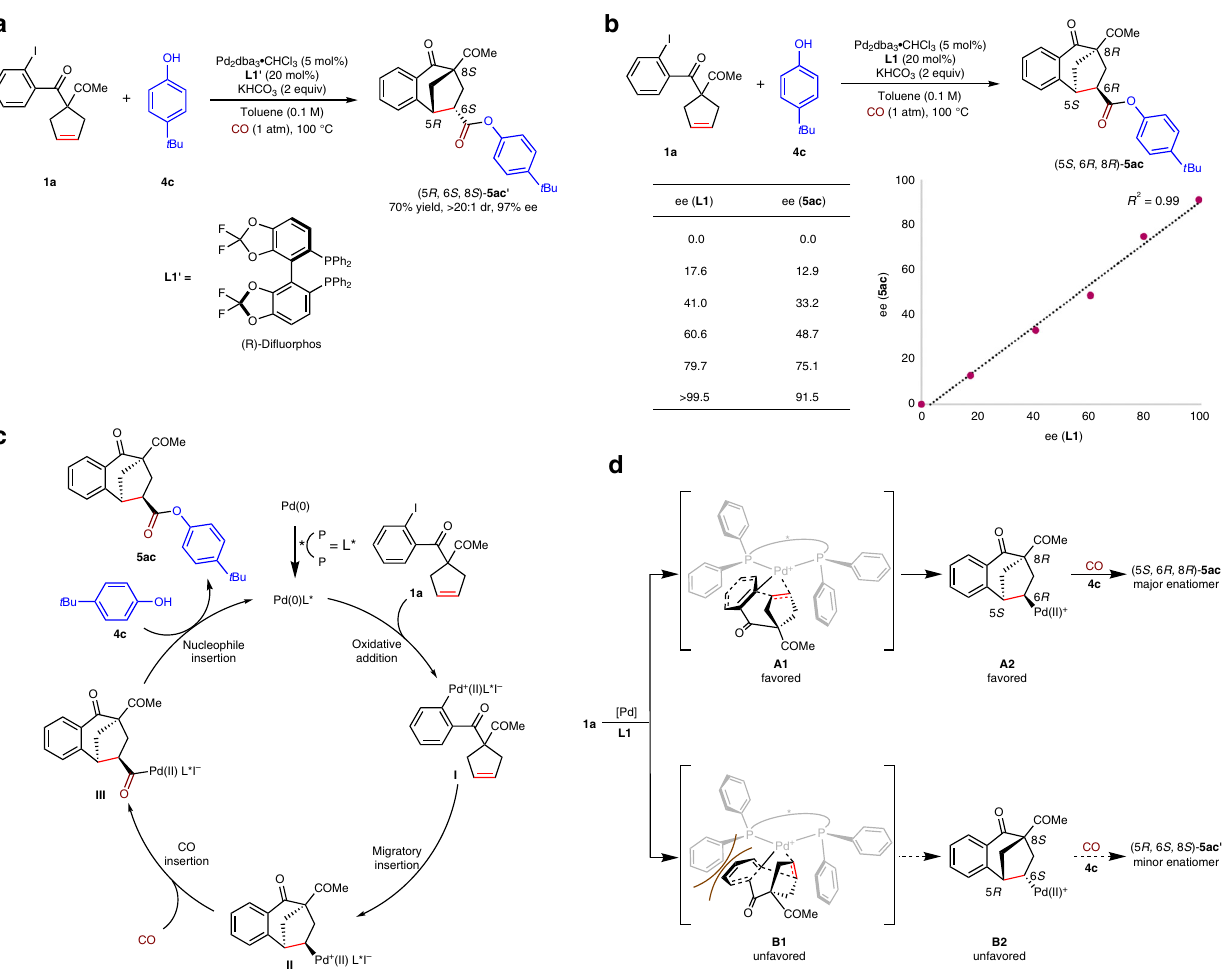
Fig. 5 Further study on the reaction. a Enantiodivergent synthesis of (5 R , 6 S , 8 S )- 5ac ′ . b Linear correlation between the ee values of 5ac and L1 . c Proposed mechanism. d Model for